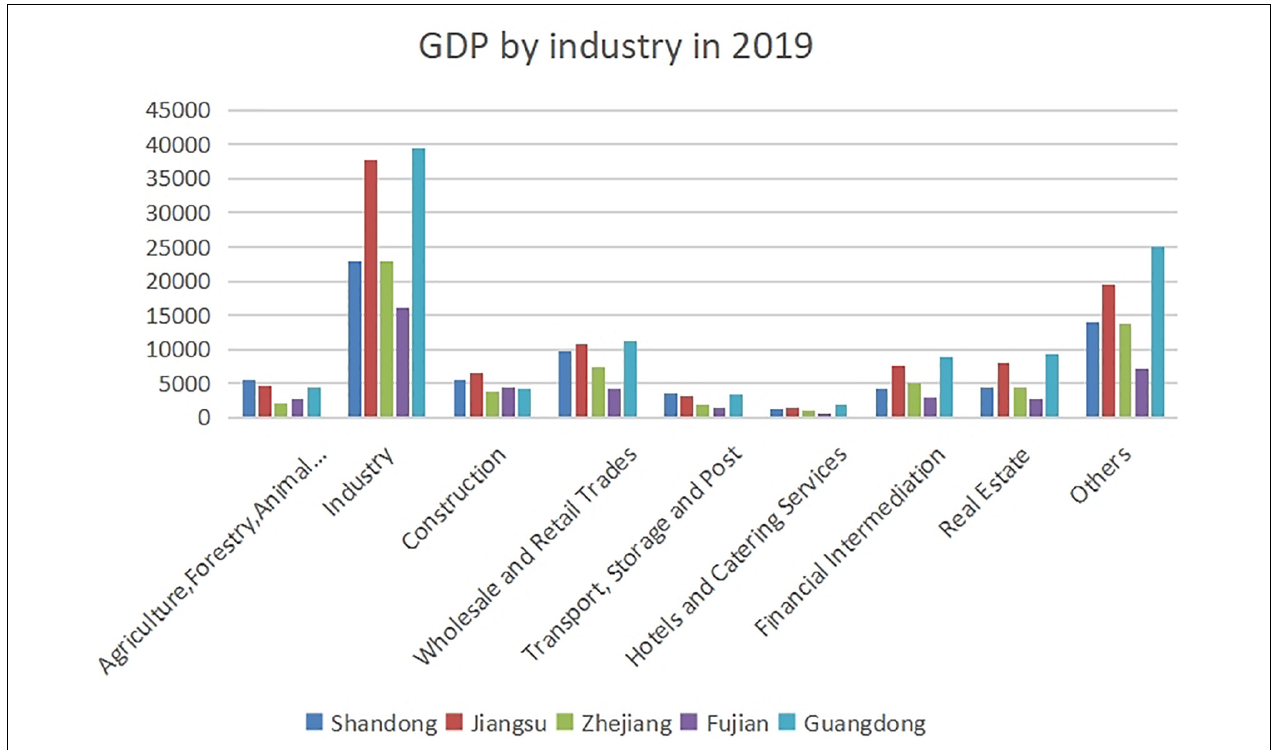
FIGURE 4 | GDP by industry in the five